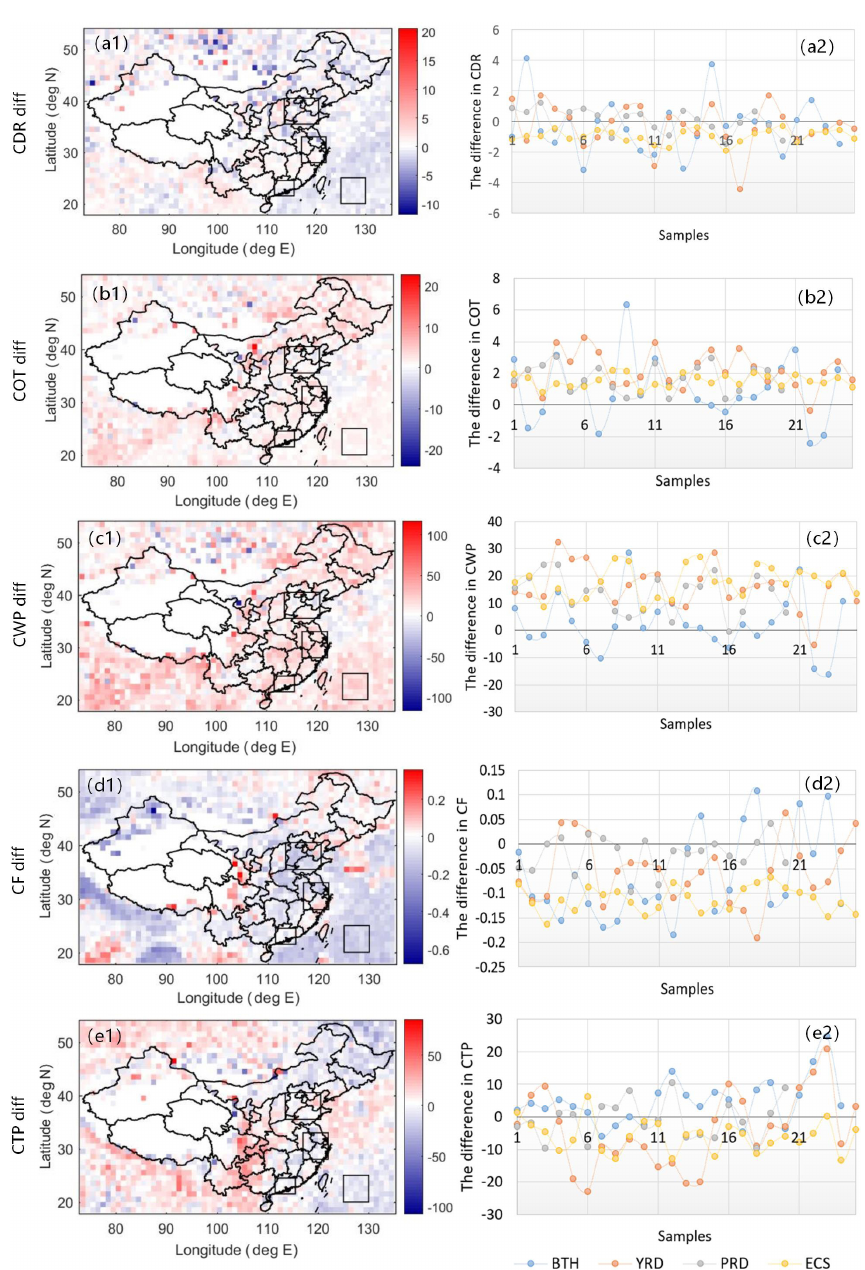
Figure 5. Spatial distributions of differences in cloud properties (CDR, COT, CWP, CF and CTP) between Aqua and Terra overpasses (3h) for the lowest MODIS/Terra AOD quartiles (left, a1–e1 ). Sample series of the differences in cloud properties (CDR, COT, CWP, CF and CTP) between the values at the start time and the end time of the time step for the lowest MODIS AOD quartiles (right, a2–e2